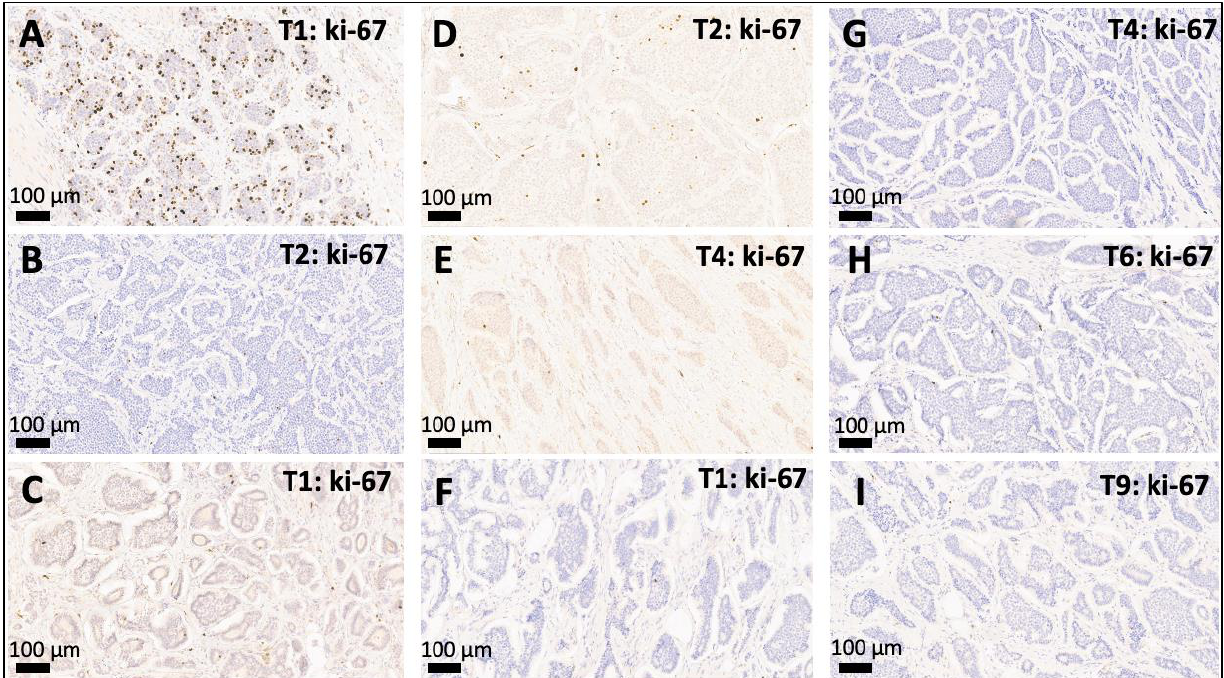
Figure 2. Intertumoral variation of WHO grade (G1 – G3) between multifocal SI-NETs. ( A , B ): Discordant multifocal SI-NET with a G3 leading primary NET with a proliferation activity of 21% ( A ) accompanied by a smaller synchronous G1 NET with a proliferation rate of <1% ( B ). ( C – E ): Discordant multifocal SI-NET with a G1 leading primary NET (( C ), proliferation < 1%) accompanied by one smaller synchronous G2 NET with a slightly elevated proliferation rate of 3.5% ( D ) and another G1 SI-NET ( E ). ( F – I ): Example of a concordant multifocal SI-NET where the leading primary G1 NET (( F ), proliferation < 1%) is accompanied by multiple smaller lesions that are also G1 ( G – I ), proliferation < 1%). Depicted are the leading primary NET and selected smaller synchronous jejunoileal NETs (20×) from patients with multifocal SI-NETs: T1: leading primary NET, T*: number of the respective smaller synchronous NET within the same patient. WHO grade: G1 (ki-67 index < 3%), G2 (ki-67 index 3 – 20%), and G3 (>20%).